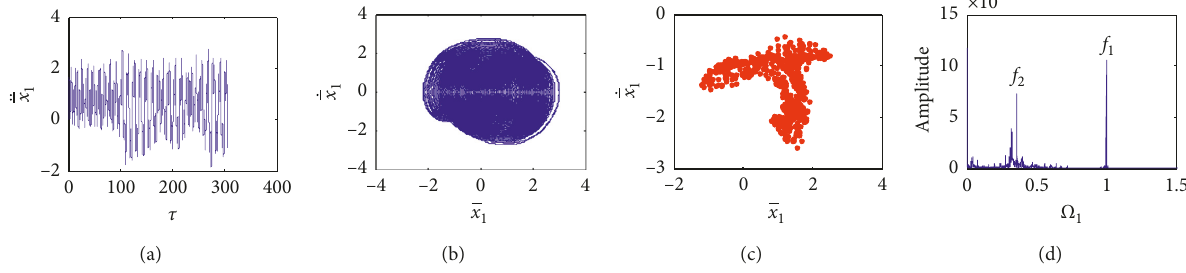
Figure 9: Vibration characteristics when Ω � 1.6: (a) time domain, (b) phase diagram, (c) Poincar´e section, and (d) frequency domain. 1